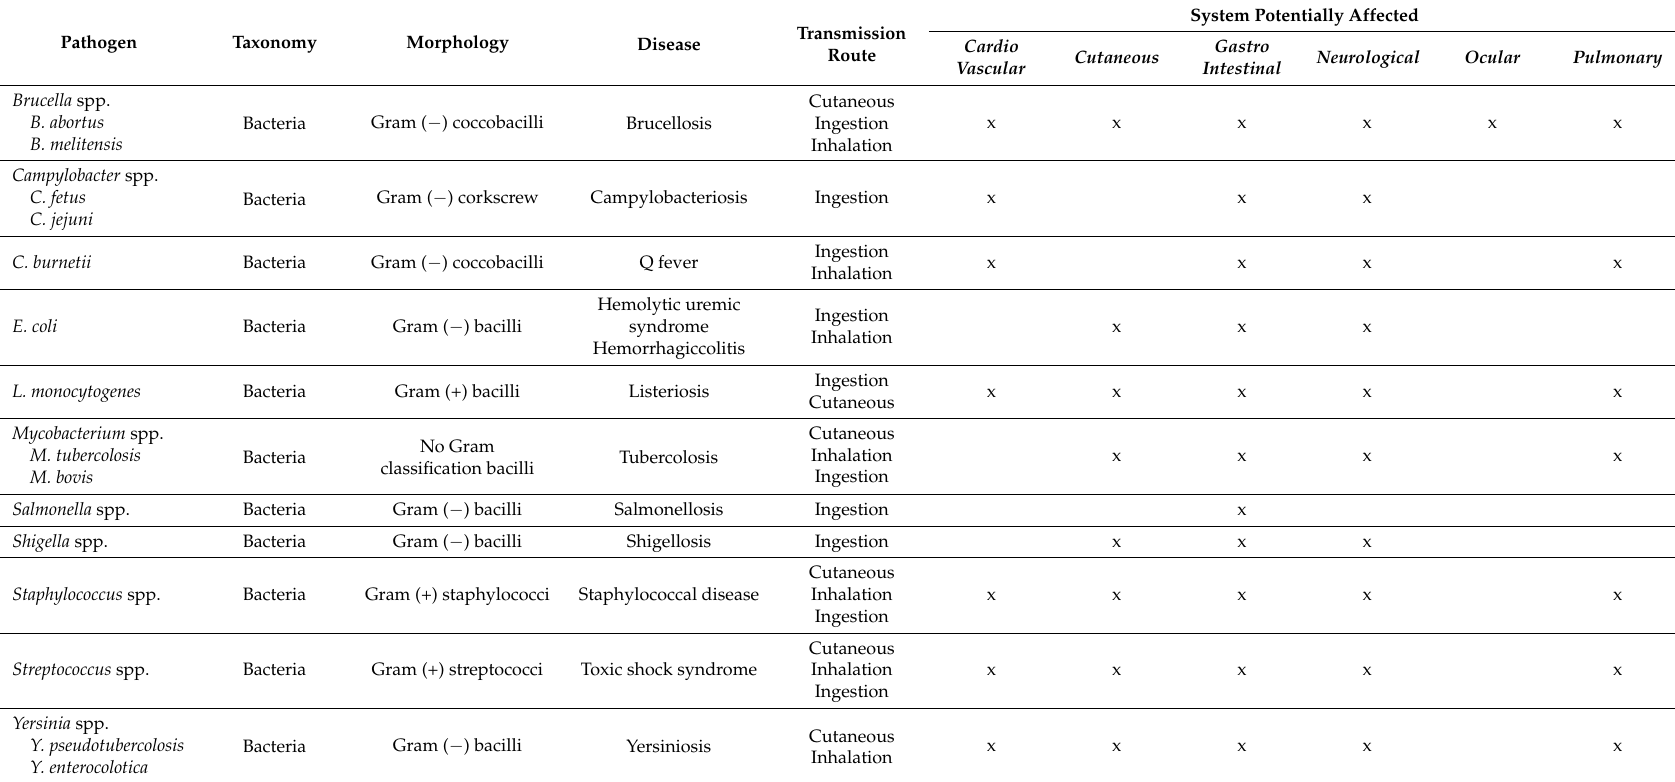
Table 2. Main raw milk pathogens and related zoonoses 1